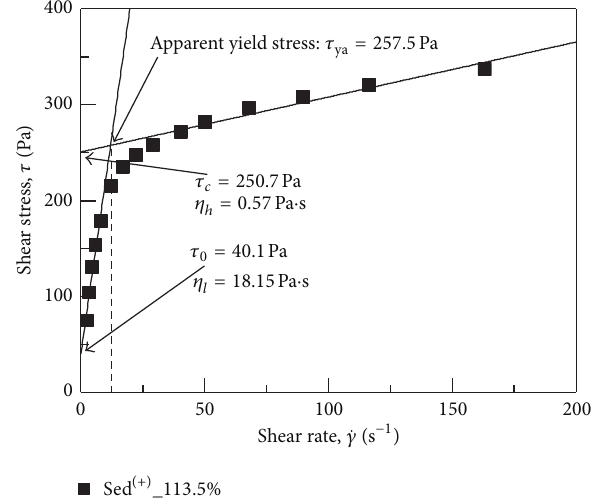
Figure 3: Determination of dynamic yield stress, Bingham yield stress, plastic viscosity of low shear rate region, and plastic viscosity of high shear rate region for the Group Sed (+) sample at a water content of